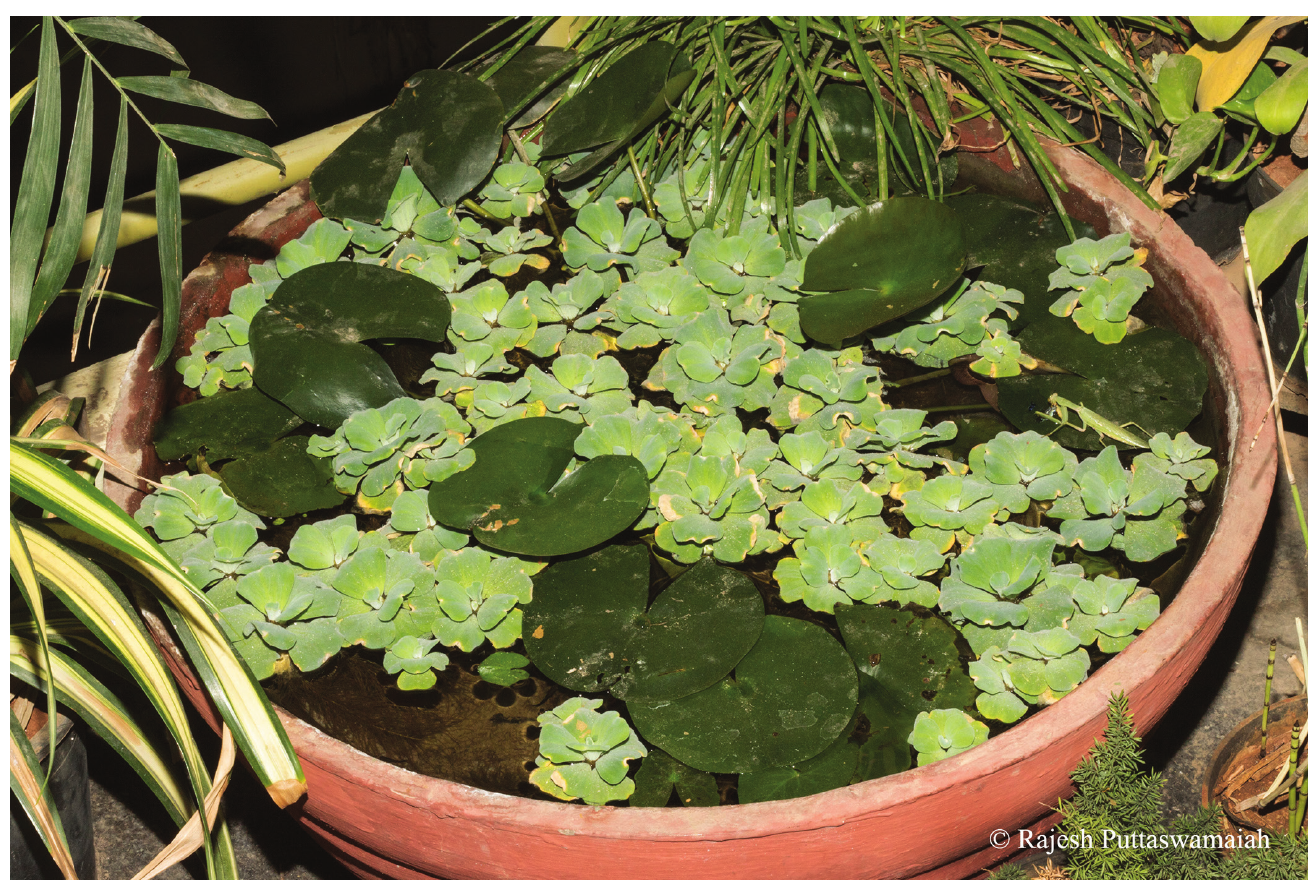
Fig. 1. The artificial pond with the male of Hierodula tenuidentata eating a Poecilia reticulata . Photo by R.